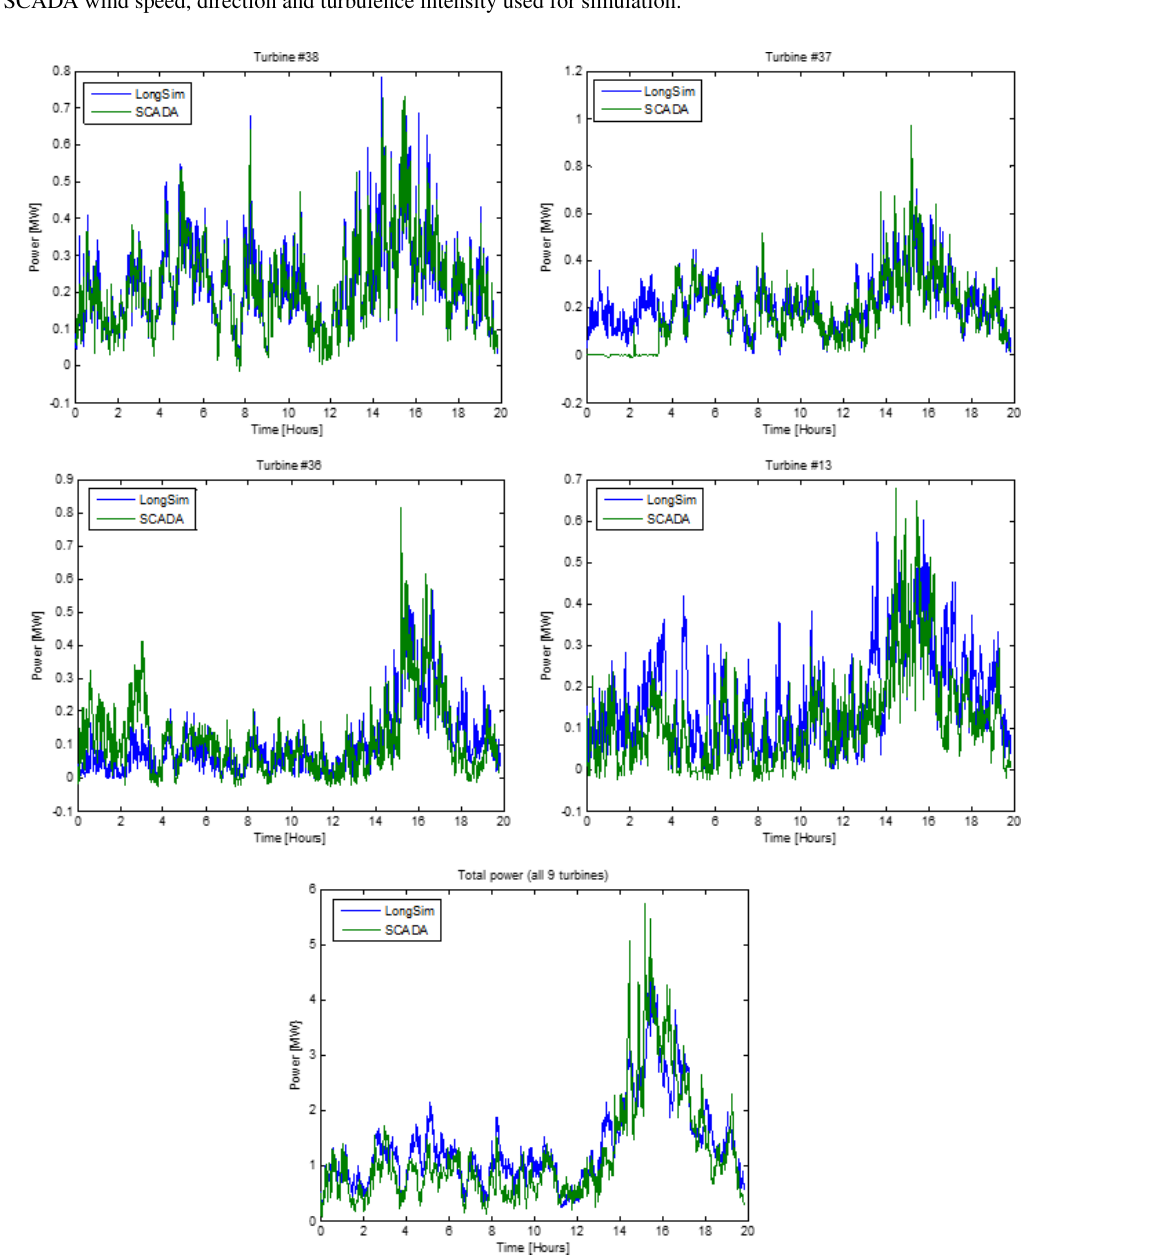
Figure 22. Measured and predicted power at turbine nos. 38, 37, 36 and 13 and the total of the nine turbines.